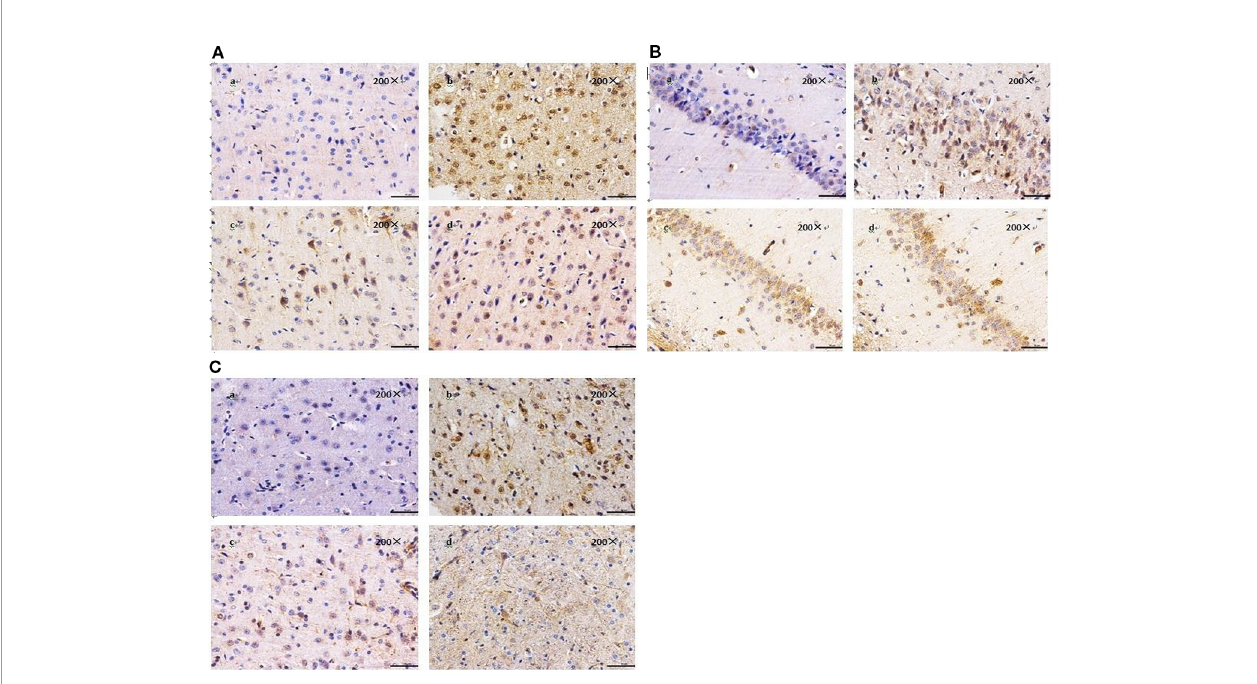
FIGURE 4 | Effect of BZP on the expression of 15-LOX-2 in Cortex, Hippocampal and Striatu in MCAO rats under inverted microscope (200×). (A) Morphological changes in Cortex; (B) Hippocampal; (C) Striatum. The groups were as follows: (a) Sham group, (b) Model group, (c) BZP (10 mg/kg), (d) C8E4 (10 mg/kg).